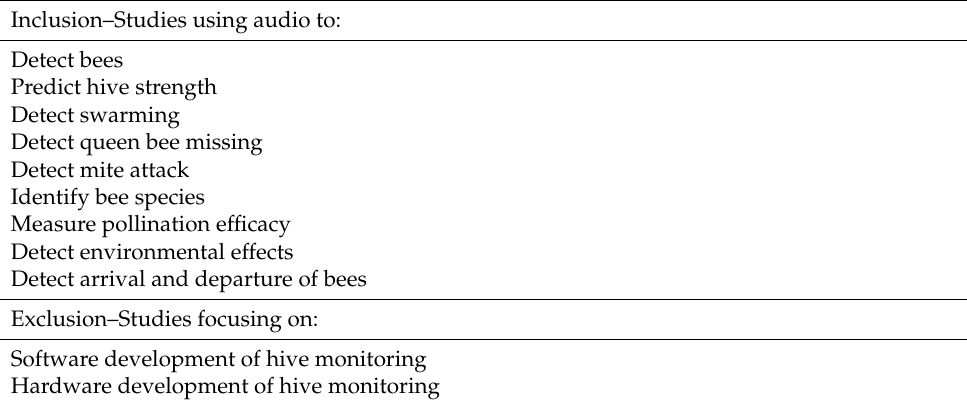
Table 1. Eligibility criteria for inclusion and exclusion of